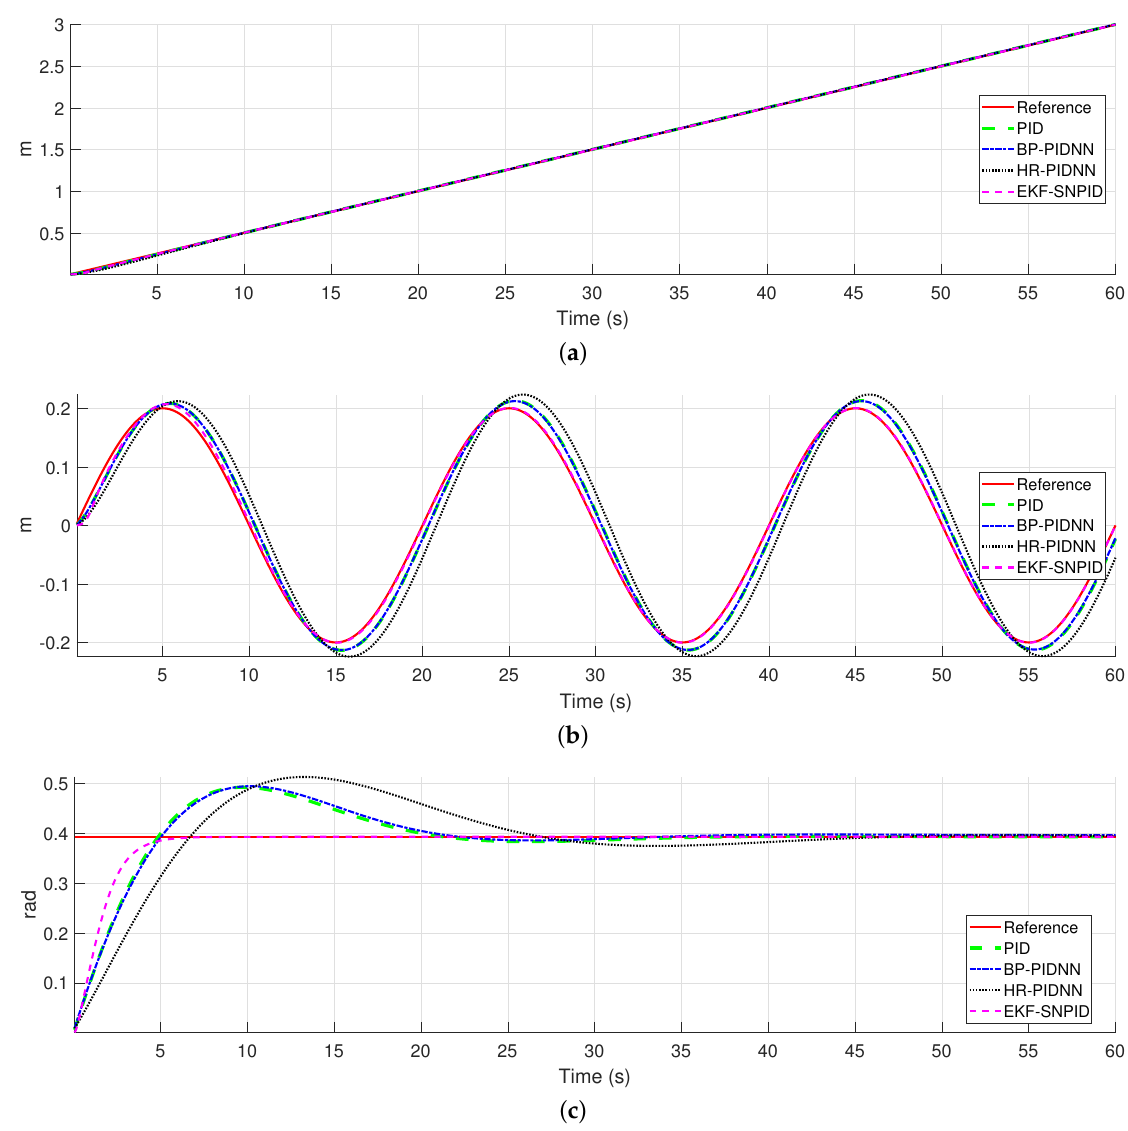
Figure 11. System response for the sinusoidal trajectory. ( a ) System response for x . ( b ) System response for y . ( c ) System response for θ .